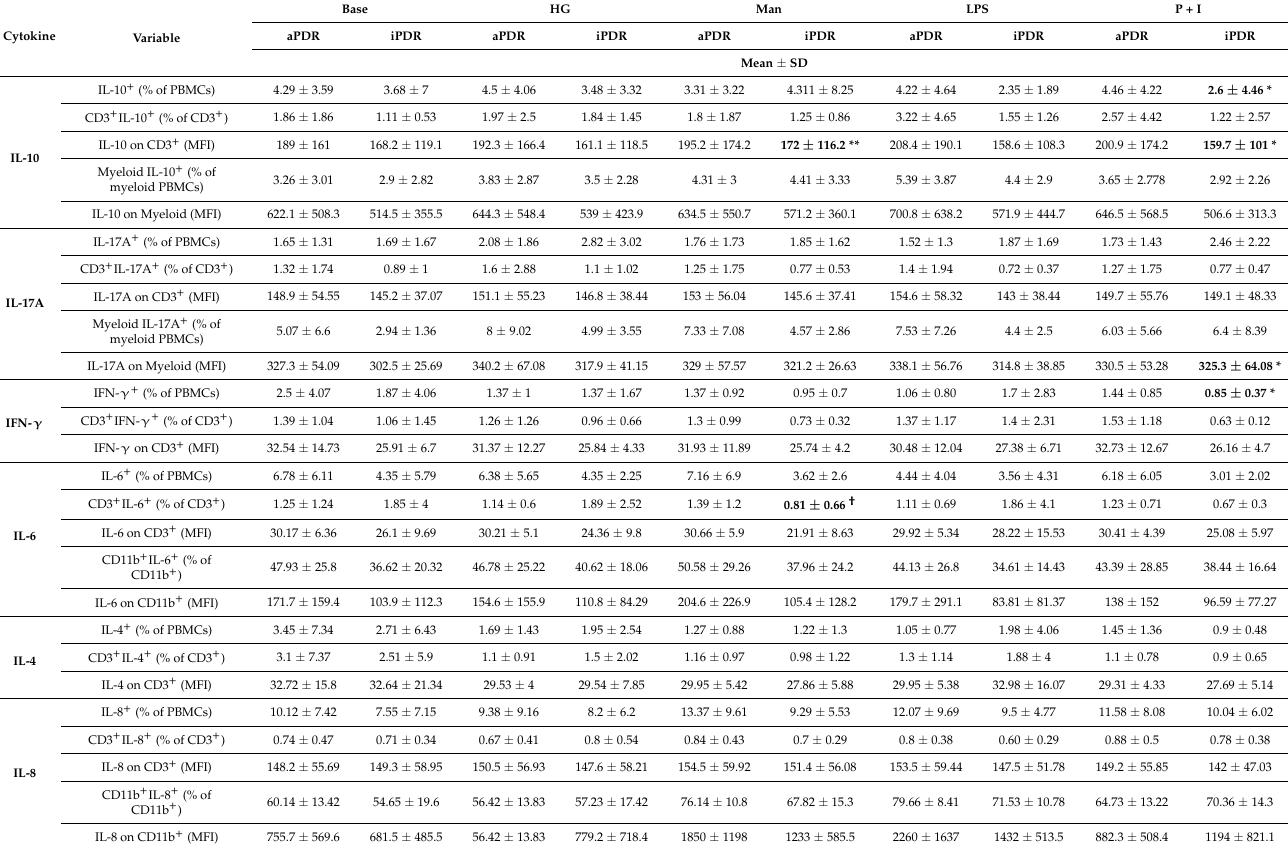
Table A6. Cytokine expression of PBMCs from aPDR vs. iPDR patients in different culture